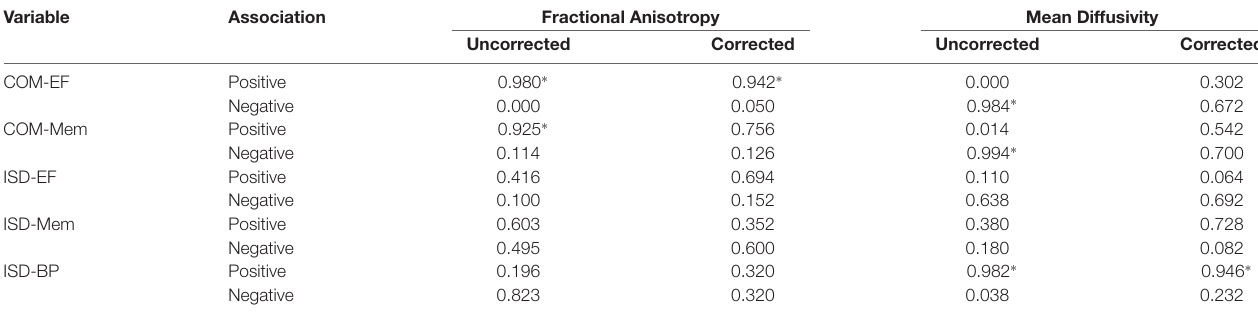
TABLE 3 | Critical values at which the threshold-free cluster enhancement (TFCE) statistic can be thresholded to yield a familywise error rate of 5% for fractional anisotropy (FA) and mean diffusivity (MD). Variable